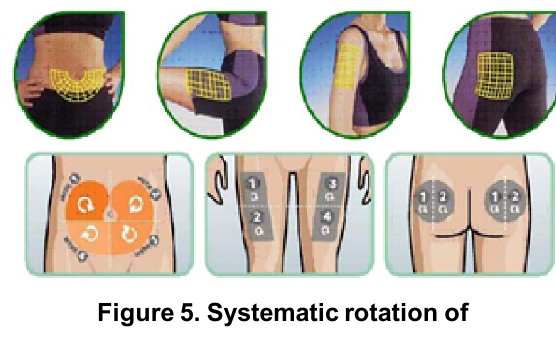
Figure 2. Safe disposal of injection devices. Selection of needle length Figure 3. Needle length in specific patient Figure 4. Injection site.